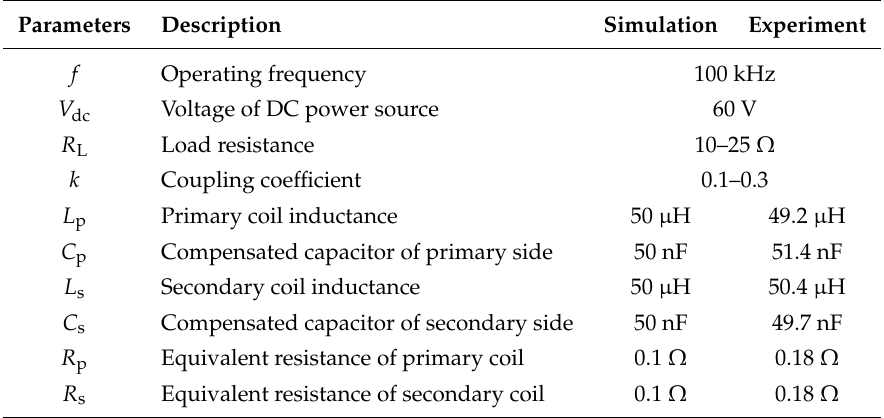
Figure 14. Simulated waveforms of transmitted bits (Data in), resonant currents ( i p and i s ) and received bits (Data out). ( a ) Forward communication with 25 kbps data rate. ( b ) Backward communication with 50 kpbs data rate. Table 4. Parameters of simulation and